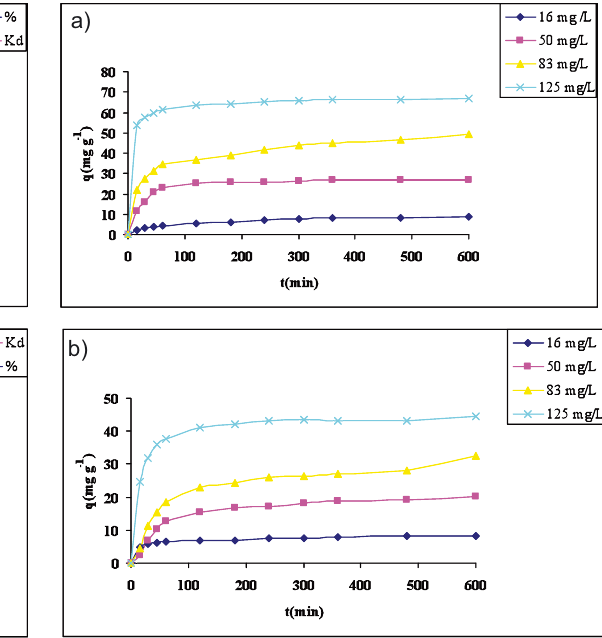
Figure 2. pH effect of Ag(I) sorption on a) As 13P, b) As 14P and c) As 15P (0.01 g resin, C =5 mg L -1 , T=25 o C, 24 hours o contact